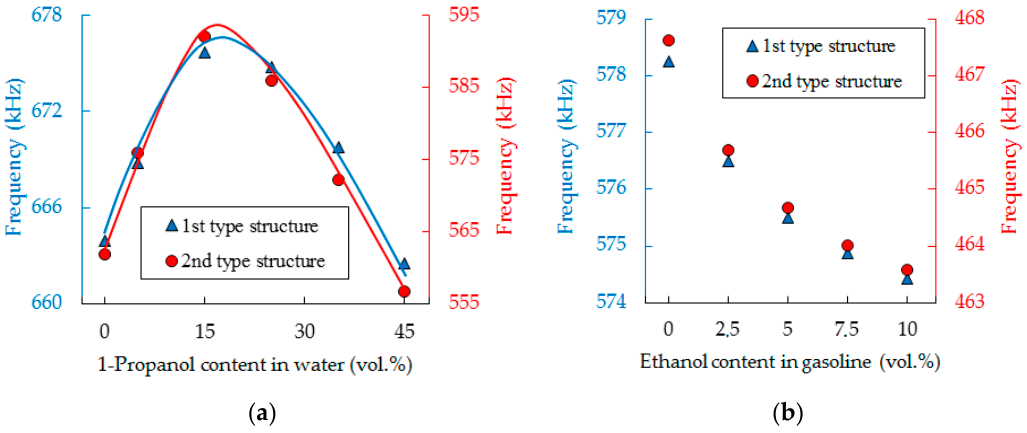
Figure 9. Summary plots for the two different experimental sensor responses on water-1-propanol ( a ) and gasoline-ethanol ( b ) mixtures. The solid lines show the modeling result based on data published in [54]. Markers show our experimental